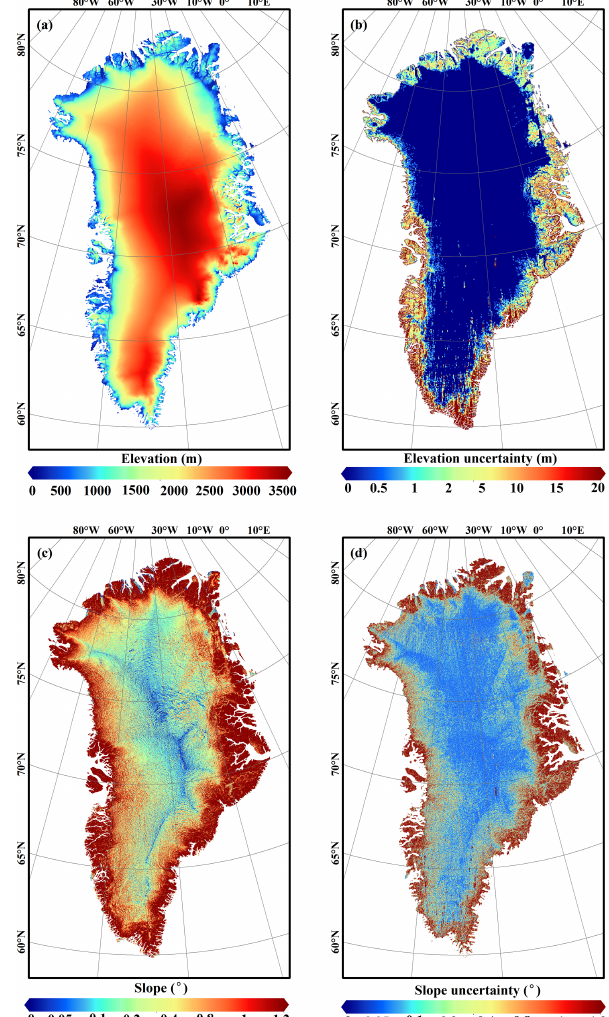
Figure 4. (a) Elevation of the Greenland DEM calculated from 13 months of ICESat-2 footprints acquired between November 2018 and November 2019. (b) The elevation uncertainties. (c) Slope de- rived from the elevation map (a) . (d) Slope uncertainty derived from the elevation map (b)